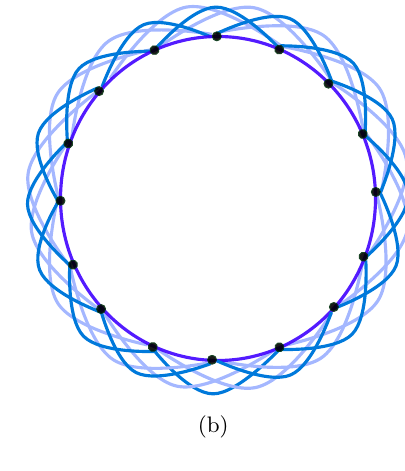
Figure 5 . (a) The initial state in eq. (3.4) has only nearest neighbor entanglement bonds. (b) Under time evolution, further neighbor bonds are